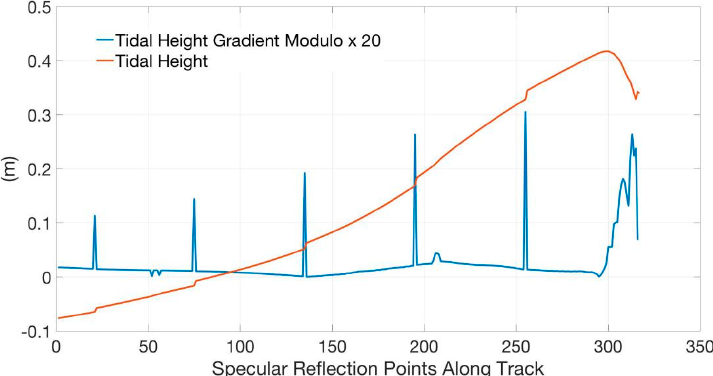
Figure 5. Tidal height (red curve) and its gradient modulo (blue curve) of the specular points by the OTCP method on a deep sea ‐ offshore track.